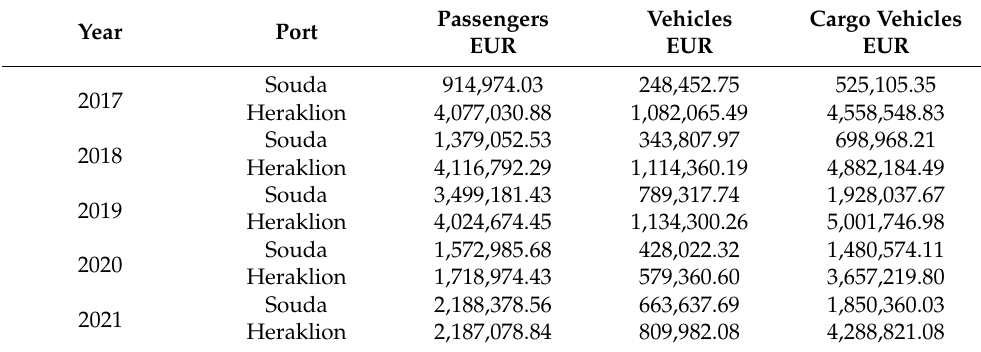
Table 9. Allocation of total annual external costs per transportation category (passenger